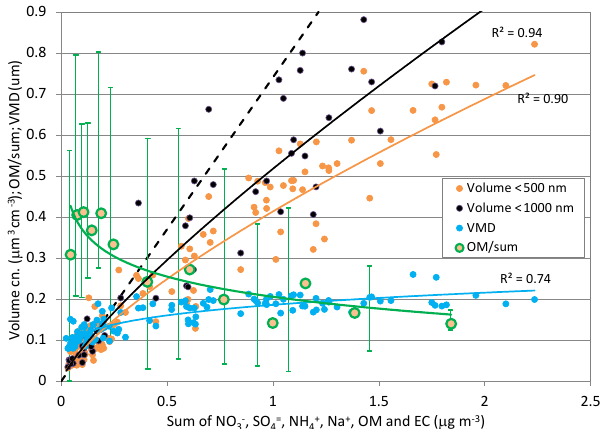
Figure 3. Scatter plot of volume concentrations, ratio of OM to the sum of other measured chemical components (NO − Na + and EC) and particle sizes (from SMPS) as a function of the “sum” of all major chemical components (OM, NO − NH + , Na + and EC). Volume concentrations are shown for particles 4 <500nm diameter (SMPS only) and particles <1000nm diameter (SMPS + OPC). Values of OM/sum are averaged over successive 10 values of the “sum” to reduce scatter. The error bars represent the range of values of OM/sum for each 10-point average. The dashed curve is the volume versus mass concentration for a constant den- sity of 1.35gcm − 3 calculated using Eq. (1) as the average for the lower mass concentration points (<0.25µgm − 3 )